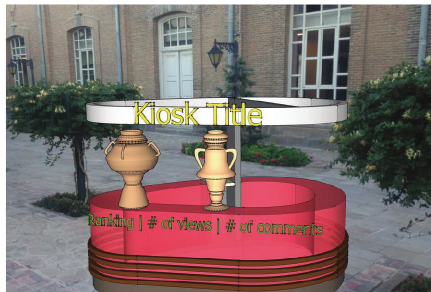
Figure 6: The AR view, watching at a kiosk from the north-west side of the kiosk.